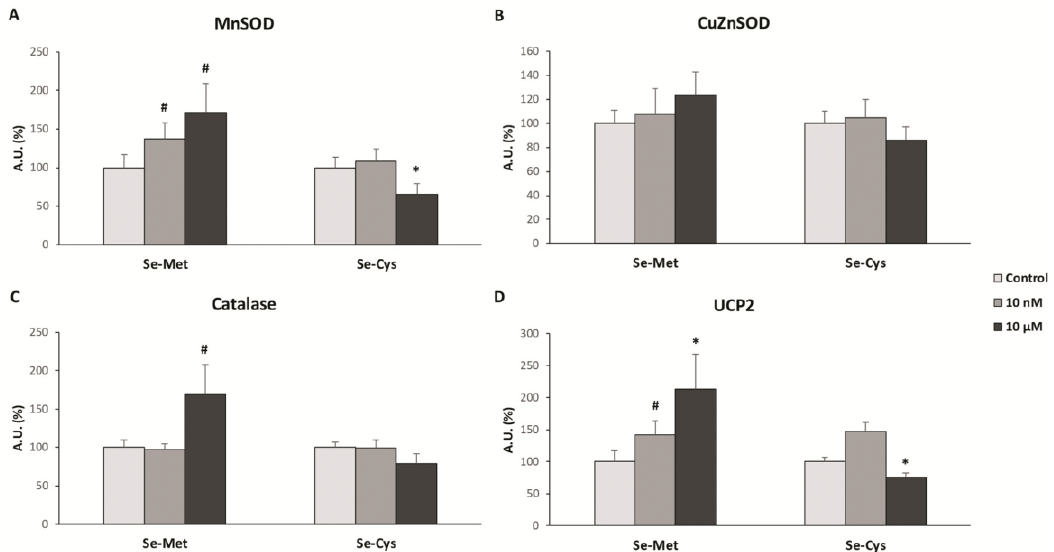
Figure 2. Antioxidant enzymes and UCP2 protein levels in MCF-7 breast cancer cell lines after treatment with selenoamino acids at 10 nM and 10 μM. The cells were treated with vehicle (clear grey bars), selenoamino acid at 10 nM (dark grey bars) or selenoamino acid at 10 μM (black bars) for 48h. ( A ) Manganese Superoxide Dismutase (MnSOD). ( B ) Copper-Zinc Superoxide Dismutase (CuZnSOD). ( C ) Catalase. ( D ) Uncoupling protein 2 (UCP2). The proteins levels were measured by Western Blot. Bars represent means and error bars represent SEM ( n = 6). The value of control cells was set at 100% and the rest of values were calculated referenced to the control set at 100%. * Significant differences between selenoamino acid treated and control cells (Student’s t-test; p ≤ 0.05). # Significant differences between selenoamino acid treated and control cells (Student’s t-test; p ≤ 0.1). AU: Arbitrary Units.